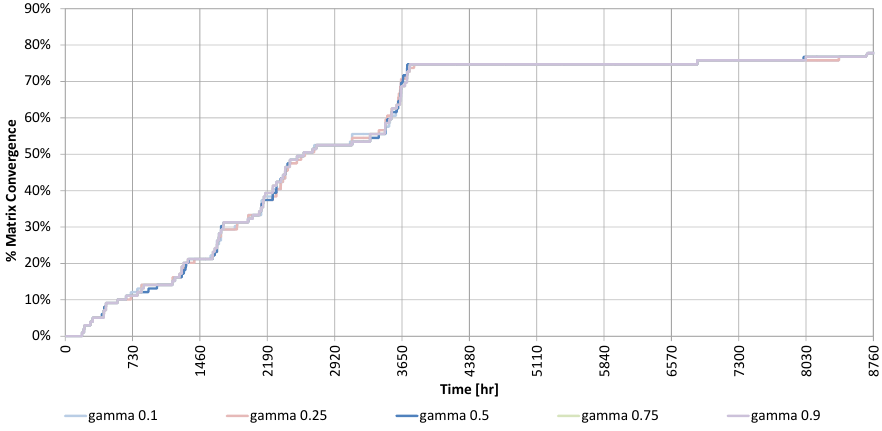
Figure 14. Convergence of learning method with different parameters gamma.